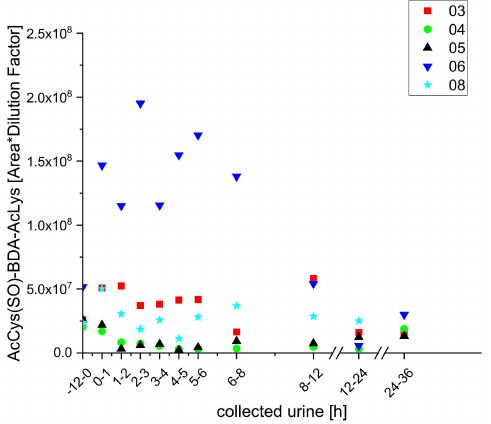
Figure 3. Excretion kinetics of AcCys-(SO)-BDA-AcLys (Rt = 4.46 min): UPLC-qToF-MS / MS measurements (as detailed in Section 3) of contents in samples of urine from participants three, four, five, six, and eight at indicated times after co ff ee consumption